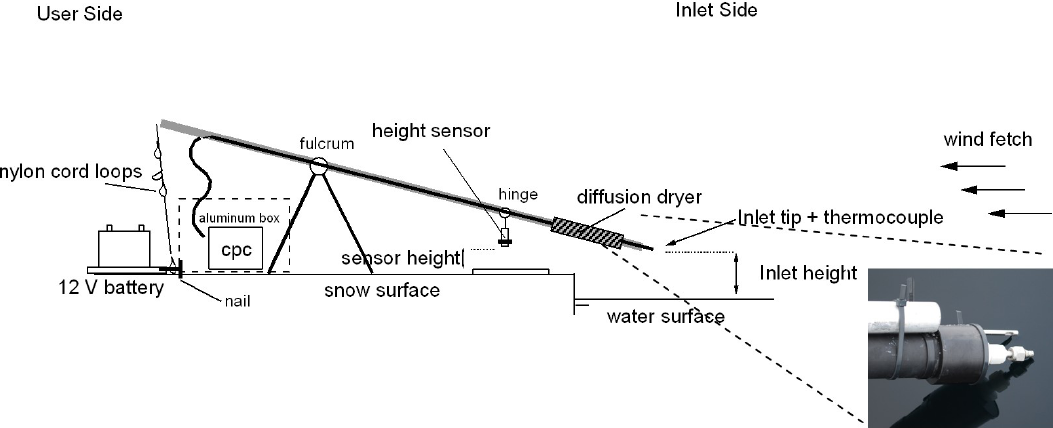
Fig. 1. Schematic of the gradient pole to measure particle number concentration and temperature profiles above snow and water surfaces. The pole is lifted up and down on the user side so that the inlet can return to various fixed heights above the